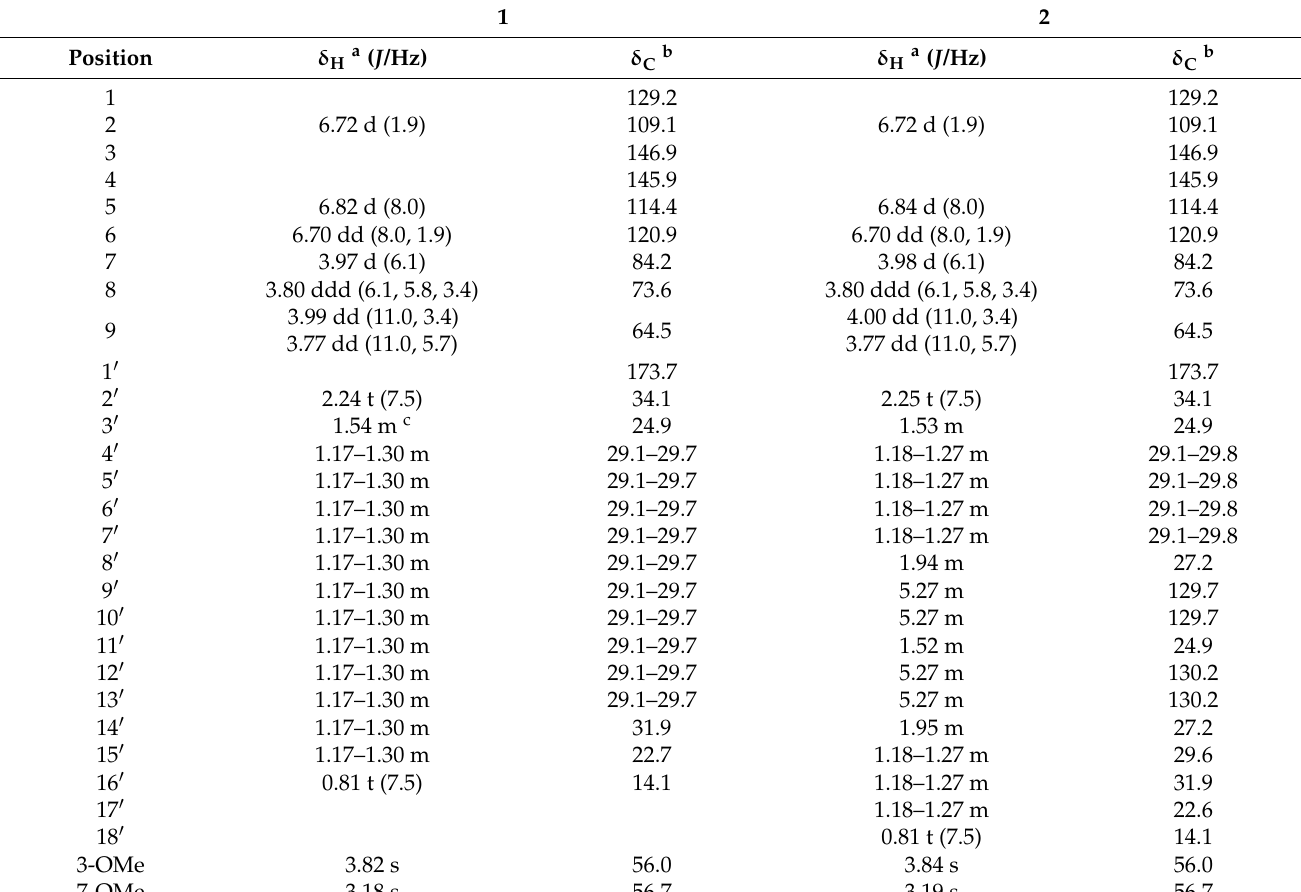
Table 1. 1 H and 13 C NMR spectroscopic data for compounds 1 and 2 in chloroform- d .